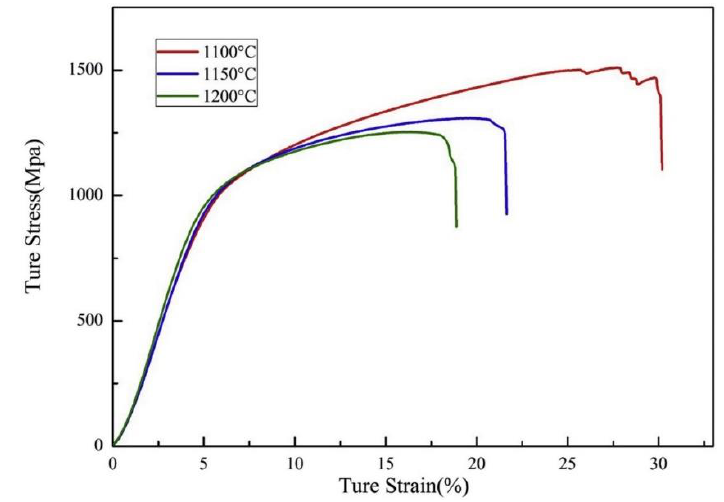
Figure 13. Stress-strain plots at room temperature (RT) of yttrium added TiAl alloys produced by SPS, reproduced from [27], with permission from Elsevier, 2020.